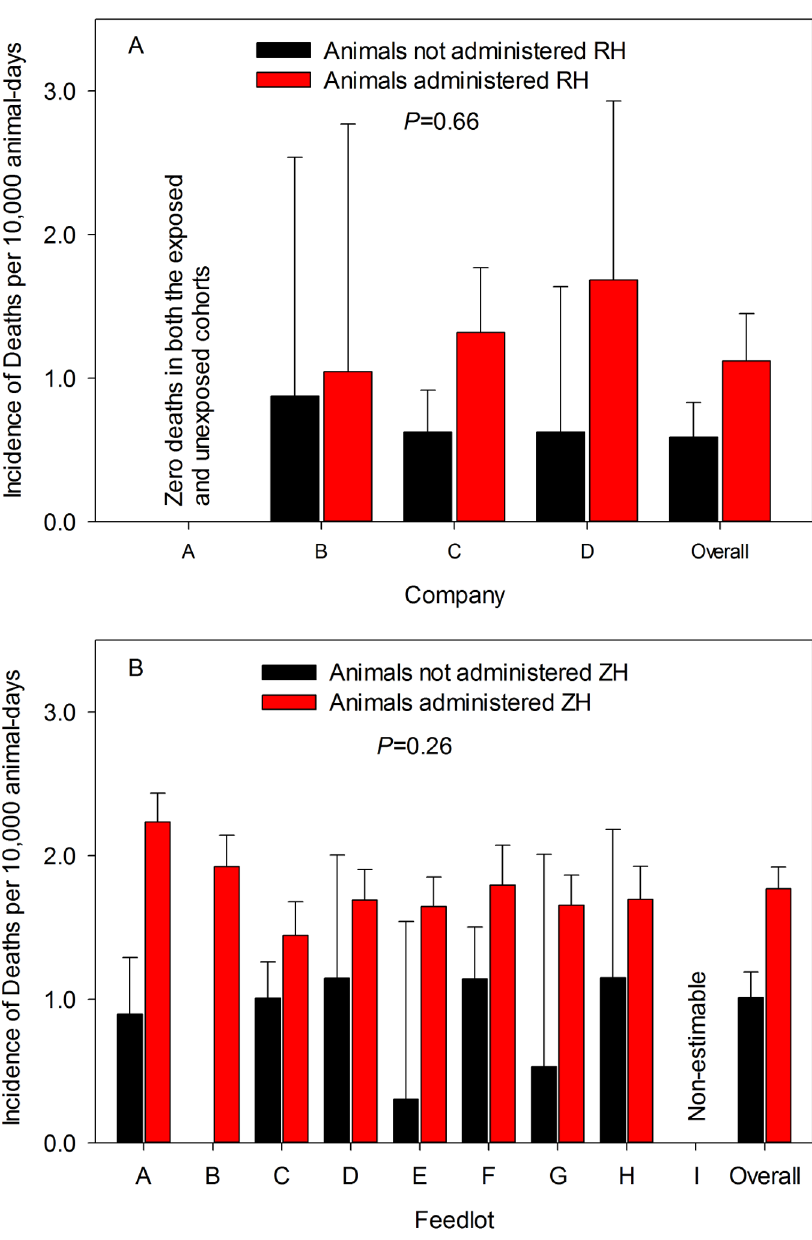
Figure 1. Association between b -adrenergic agonist administration and mortality. Model-adjusted estimates of incidence of death per 10,000 animal-days for cattle administered either ractopamine hydrochloride (RH – graph A) or zilpaterol hydrochloride (ZH – graph B) compared to a diet without a beta agonist. No deaths were reported for Company A (graph A) and rates for Feedlot I (graph B) were non-estimable. P values are those associated with interaction term for exposure by company (graph A) or feedlot (graph B). Bars represent upper 95% confidence limit. doi:10.1371/journal.pone.0091177.g001 black hide, and percent of pen treated prior to the at-risk period), the incidence of death was 80% greater in animals administered ZH than the comparative control cohort (IRR = 1.80 [95% CL = 1.55, 2.10]; P , 0.01). The association between incidence rate of death and administration of b AA, therefore, did not appear to be confounded by the covariates available for analysis. There was little evidence of feedlot-to-feedlot variation in the association between ZH and increased risk of death. In the population at-risk model, for example, the covariance parameter was much greater at the group-level (1.14 [SE= 0.03]) than that observed at the feedlot-level (0.04 [SE =0.02]). In the alternative